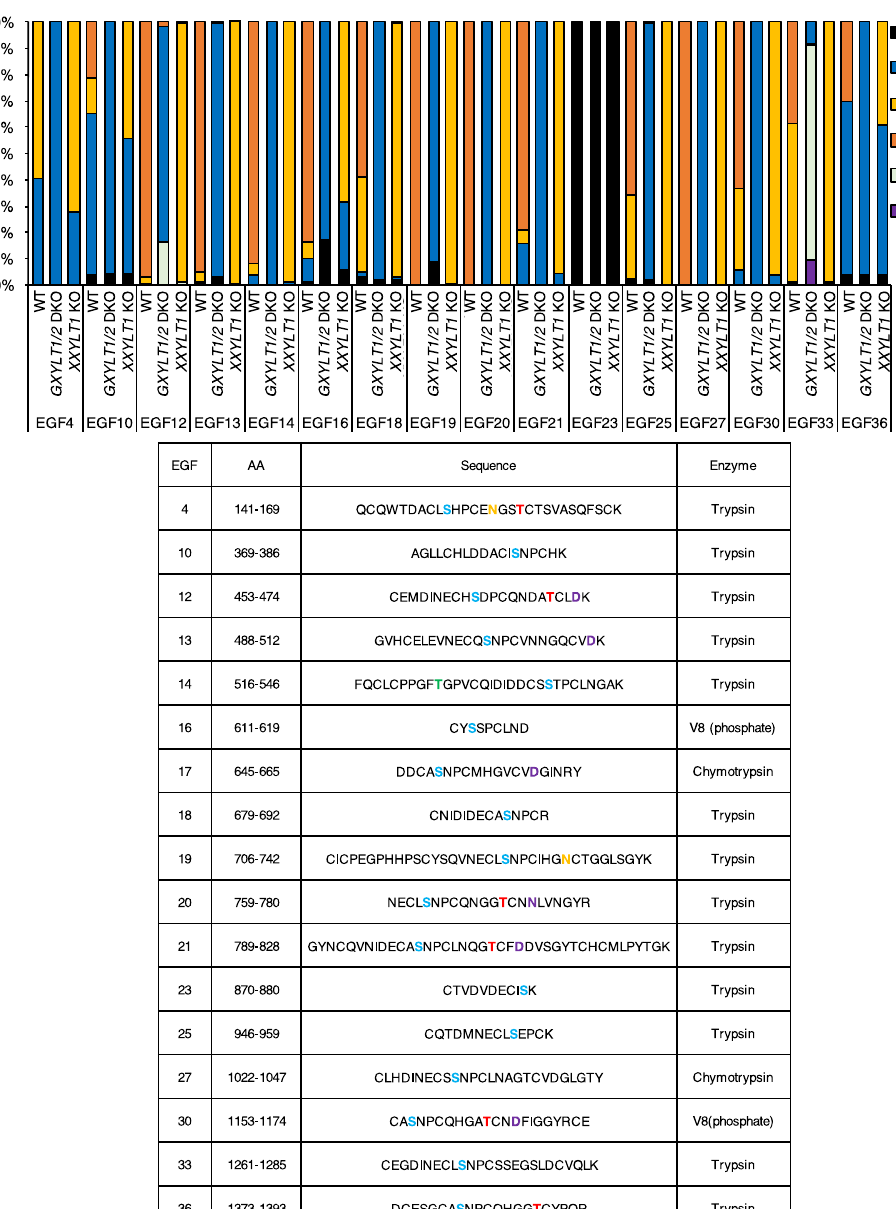
post-translational modification sites. Blue— O -Glc; red— O -Fuc; green— O -GlcNAc; yellow— N -glycan; purple— β